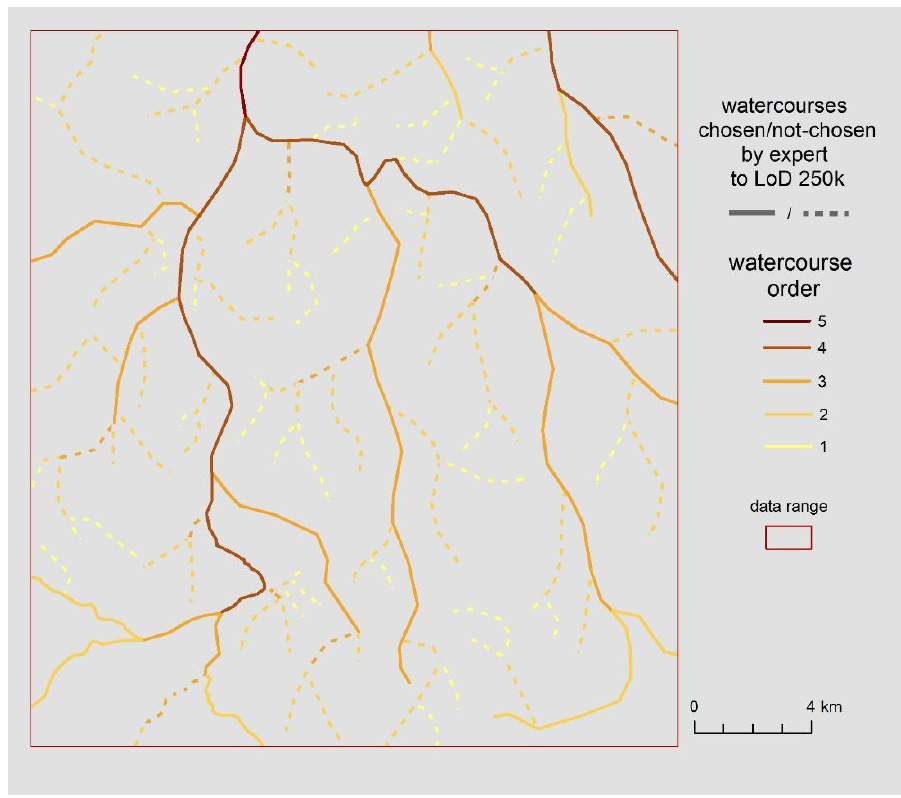
Figure 5. The expert selection of roads 10 k > 50 k (solid lines) juxtaposed with the roads attribute describing the number of intersections with other road segments (geometric atribute), visually showing the importance of the attribute discovered also within reducts.